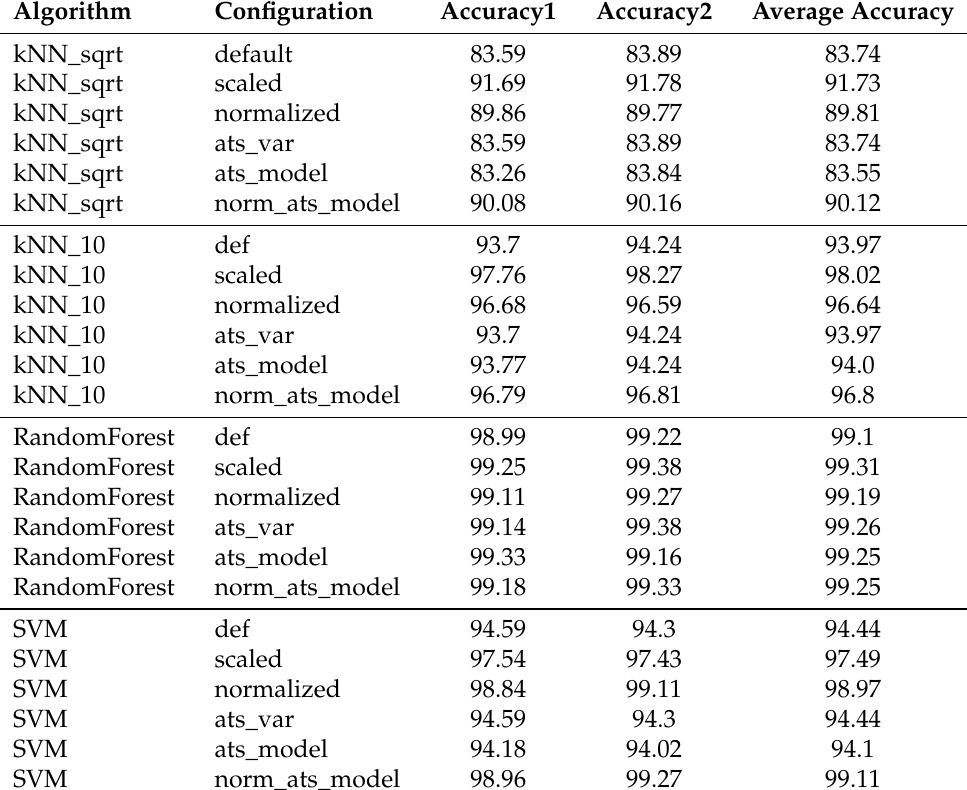
Table 3. Accuracy from different machine learning algorithms and configurations in the experiment